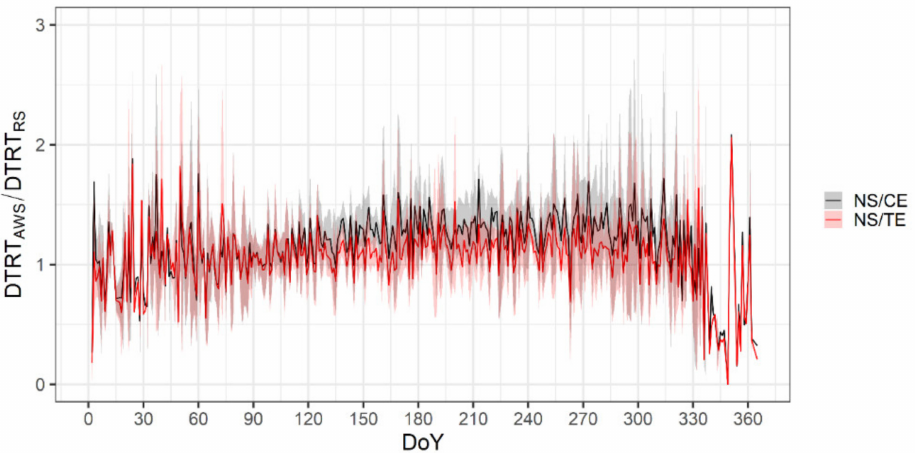
Figure 16. Seasonal variation of DTRT ratio between orchard (black) and crop canopy (red) with respect to RS climate